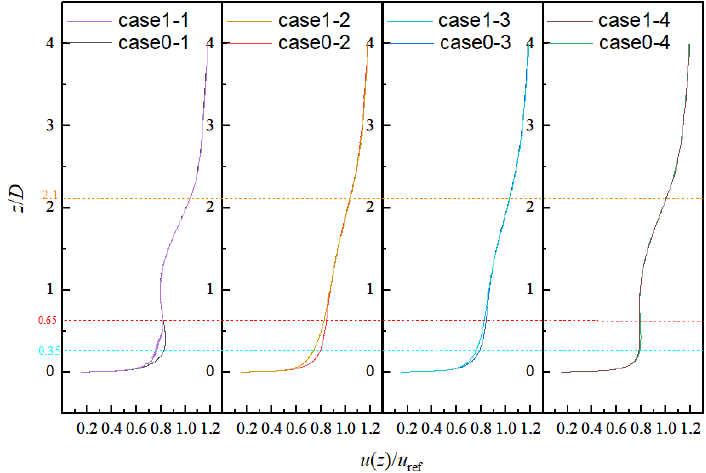
Figure 4. Comparison of vertical velocity wind profiles between Case 1 and Case 0.